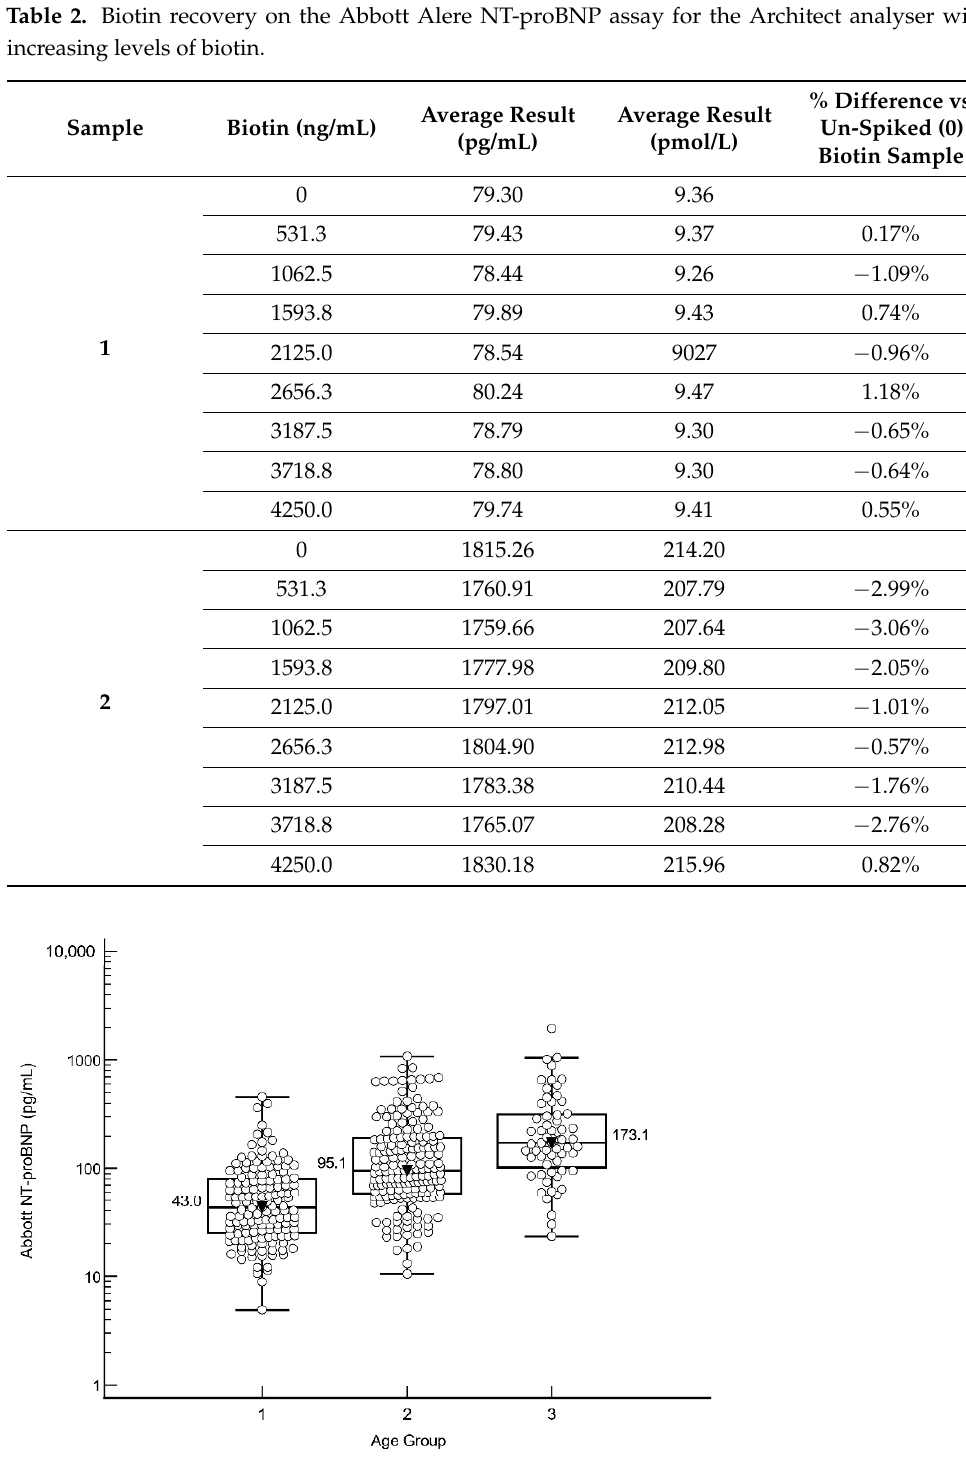
Figure 3. Abbott Architect NT-proBNP levels according to age groups. Age group 1: <50 years old, 2: 50–75 years old, and 3: >75 years old. Median NT-proBNP levels for each group is displayed. Abbreviations: NT-proBNP: N-terminal pro-brain natriuretic peptide.